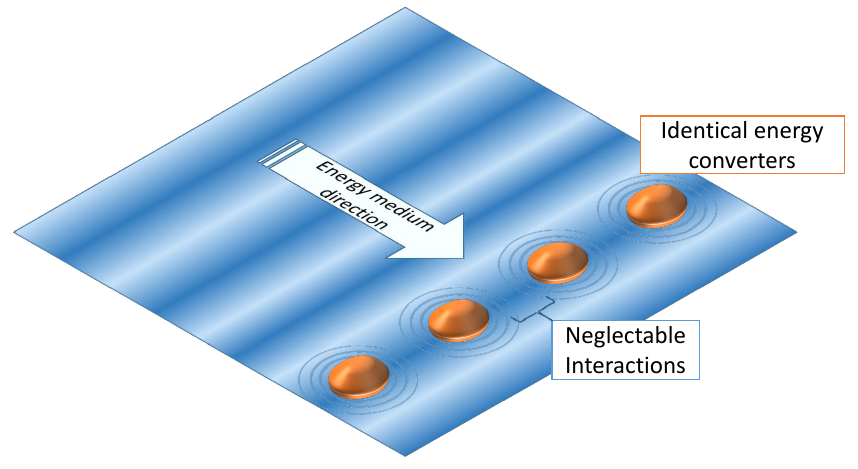
Figure 1. Sketch of an energy converter array that can be used for